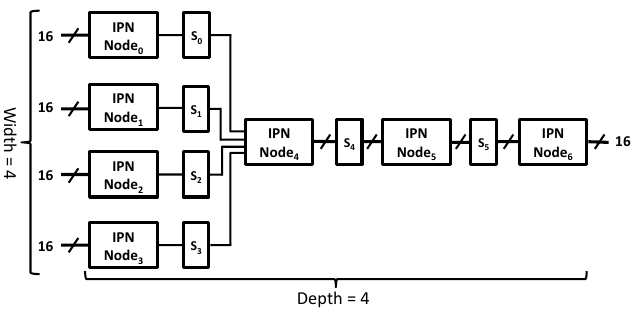
Figure 5. The IPN under test. Width = 4, Depth = 4. Labeled as IPN-4-1-1-1. Table 5. Prediction accuracy of three attack methods. Results collected from a 100,000 test set. Logistic regression: 14 days; evolution strategies: 250,000 generations, 14 days; MLP: 18